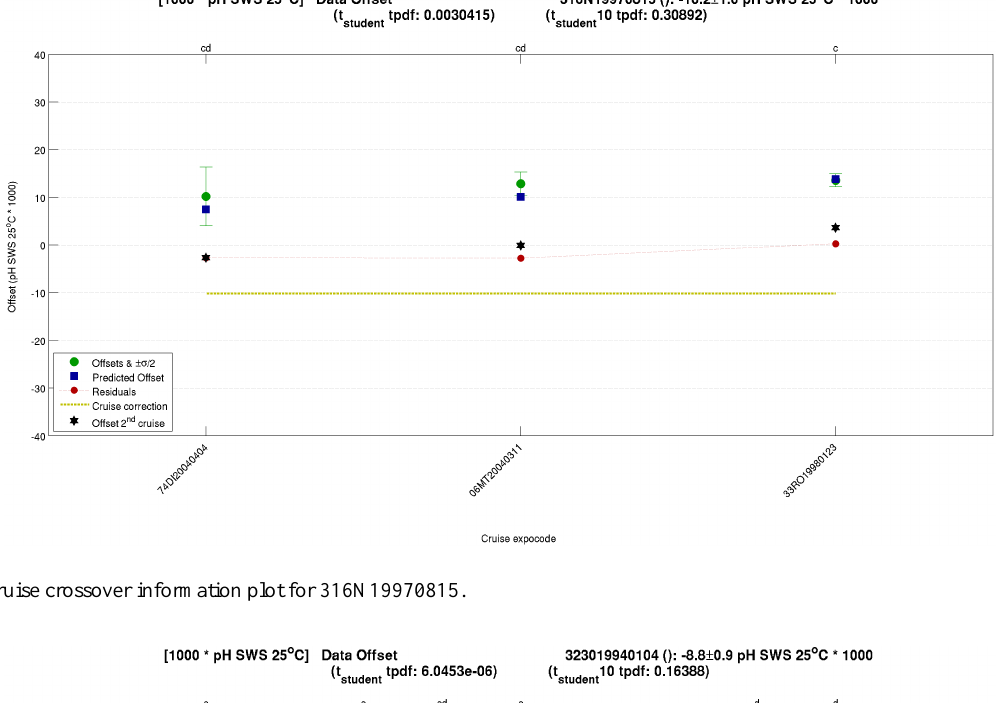
Figure 23. Cruise crossover information plot for 316N19970815.